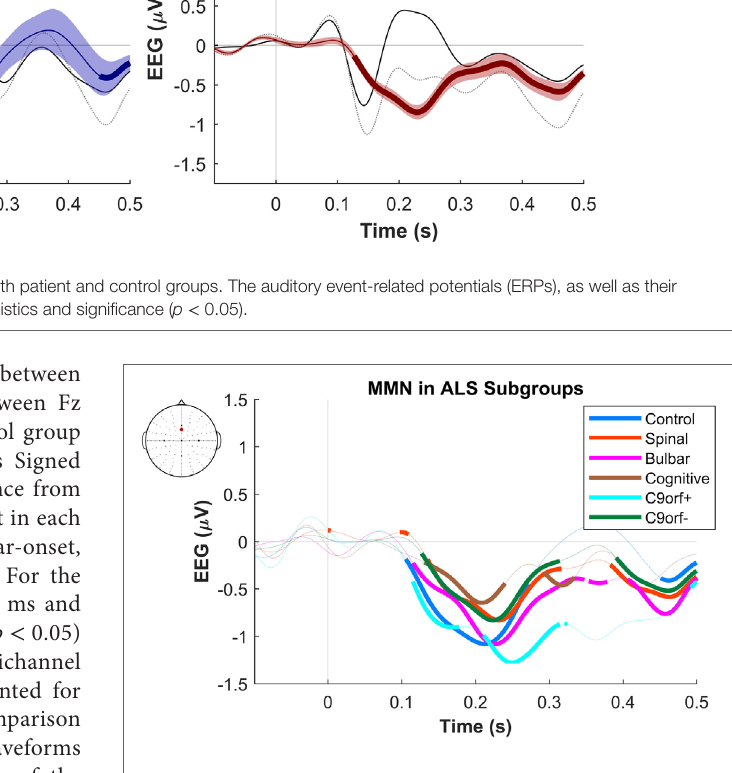
FigUre 2 | Presence of robust mismatch negativity (MMN) responses in individual patient subgroups of amyotrophic lateral sclerosis (ALS). The MMN waveforms in controls ( n = 19), spinal-onset ALS ( n = 67), bulbar-onset ALS ( n = 15), ALS-FTD ( n = 7), ALS patients with C9ORF72 repeat expansion, and with no C9ORF72 repeat expansion are shown. The thick curves indicate the significant responses ( p <